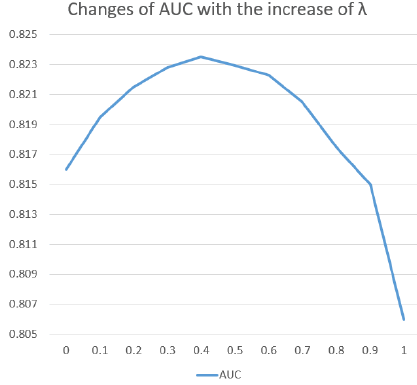
Fig. 6. The changes of AUC with the increase of λ, Y axis represents AUC and X axis represents λ